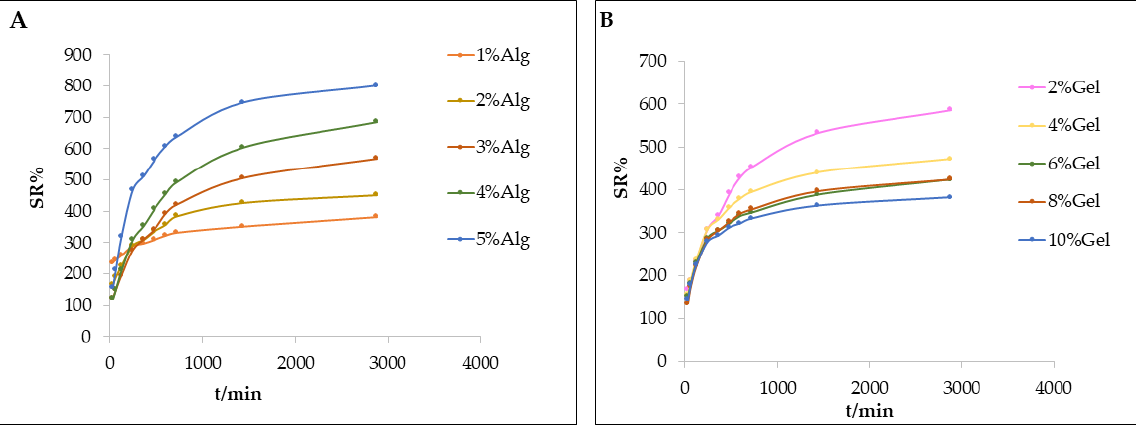
Figure 4. Effect of different ratios of ( A ) sodium alginate and ( B ) gelatin on the swelling property of composite hydrogel.